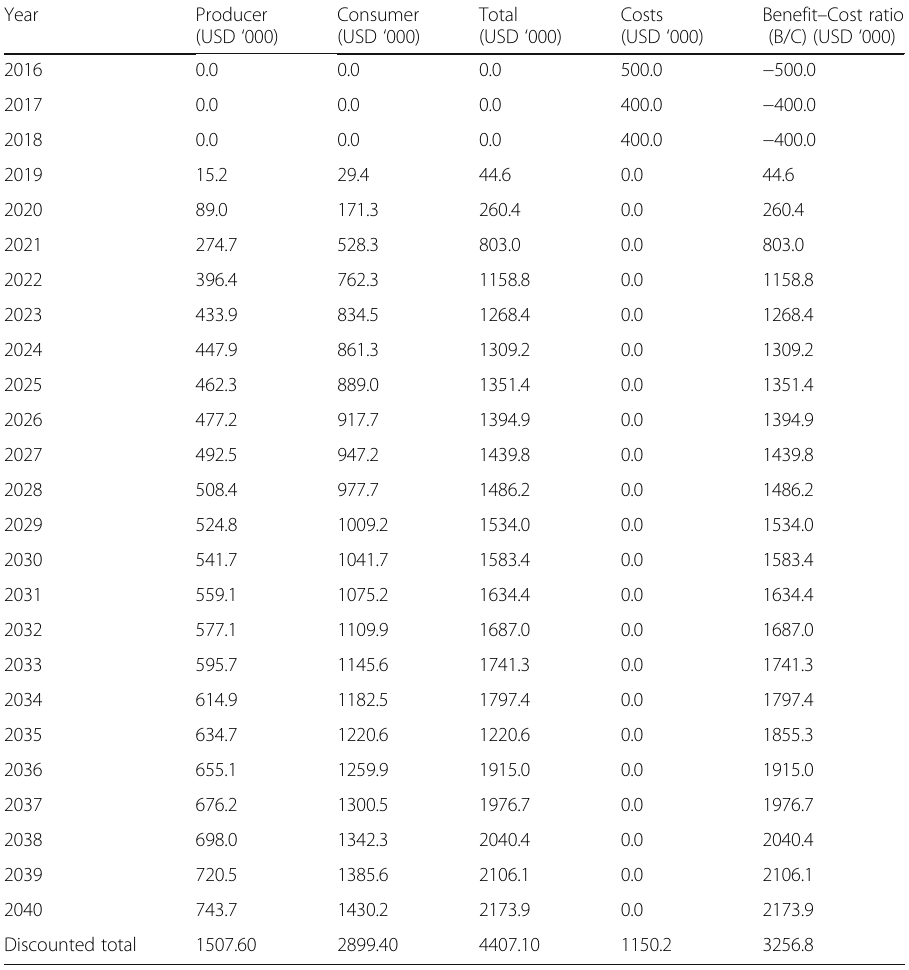
Table 3 Simulated VCF Cost and Benefit on Plantain